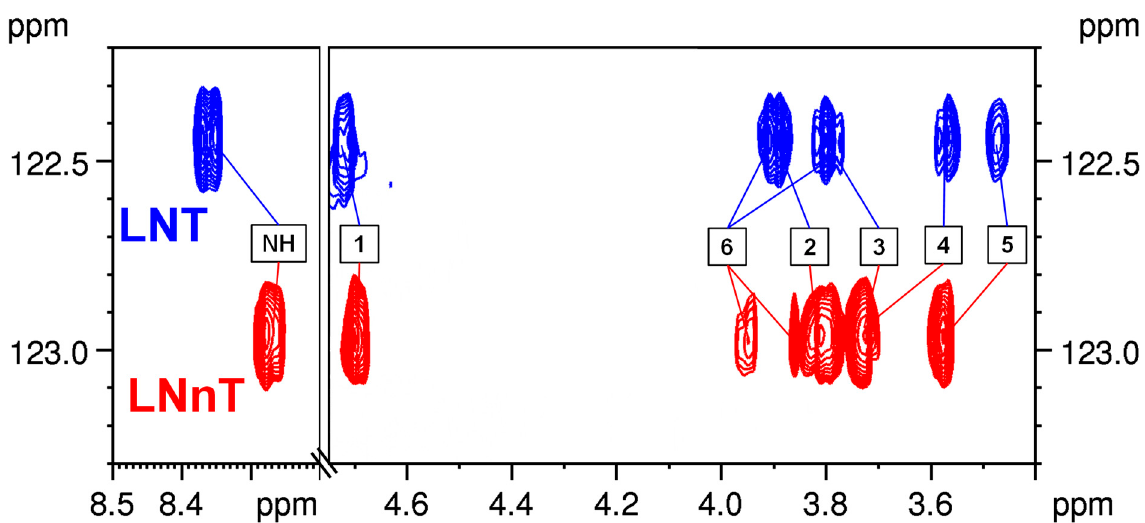
Figure 4. Overlaid 1 H- 15 N HSQC-TOCSY spectra of LNT and LNnT with the 1 H NMR assignment of their GlcNAc moiety. (The 1 H- 15 N HSQC-TOCSY spectrum of LNT and LNnT mixture can be seen in Figure S79).